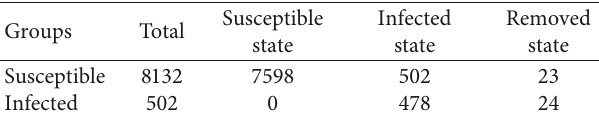
Table 2: Number of individuals at any state for HIV at the end of the period.